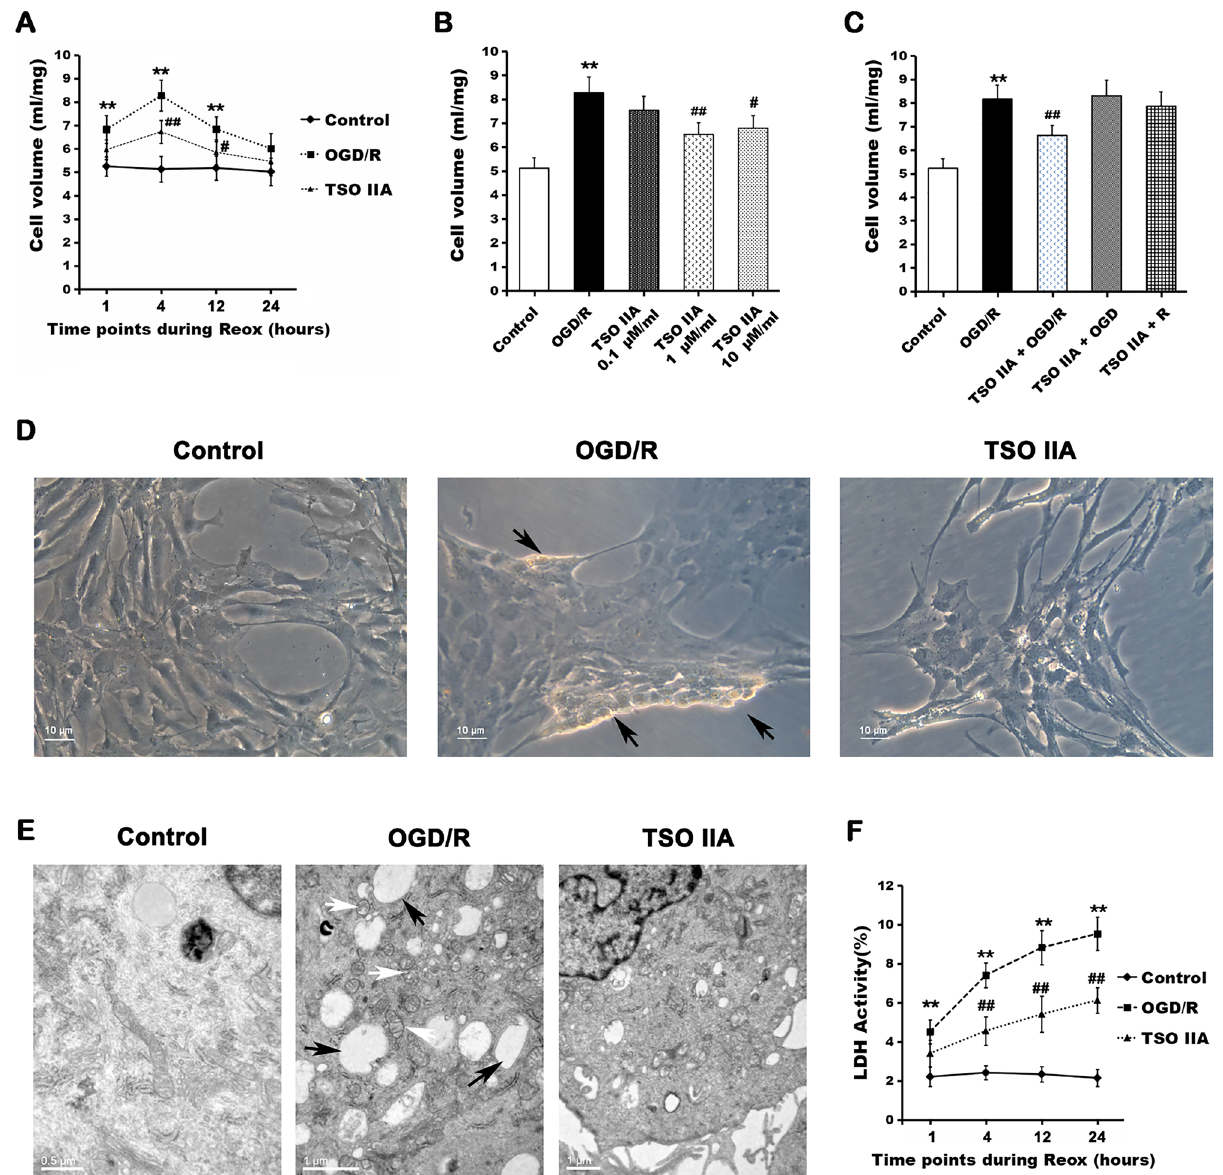
Figure 1. TSO IIA reduced astrocytic swelling and injury after OGD/R. ( A ) Cell volume quantification after OGD/R in untreated cells and cells treated with TSO IIA (1 μmol/mL) ( n = 5 independent cultures). ( B ) Dose-dependent effect of TSO IIA on cell volume. 0.1, 1, or 10 μmol/mL of TSO IIA was added 24 h before and throughout the OGD/R process ( n = 5 independent cultures). ( C ) Time-dependent effect of TSO IIA on astrocytic swelling. TSO IIA (1 μmol/mL) was added 24 h before and throughout the OGD/R (TSO IIA + OGD/R) process, only during the OGD phase (TSO IIA + OGD), or only during the reoxygenation phase (TSO IIA + R) ( n = 5 independent cultures). ( D ) Phase-contrast imaging showing cell morphological changes under different treatments. Astrocytic swelling is depicted by black arrows ( n = 5 independent cultures). ( E ) Stereoscan photographs showing an increase in lysosome number (black arrows) and mitochondria swelling (white arrows) ( n = 5 independent cultures). ( F ) LDH activity analysis showing the protective effect of TSO IIA on OGD/R injury ( n = 5 independent cultures) (The data in cell volume and LDH activity test are expressed as mean ± SEM. One-way ANOVA resulted in P < 0.01, * P < 0.05 versus the control; ** P < 0.01 versus the control; # P < 0.05 versus OGD/R; ## P < 0.01 versus